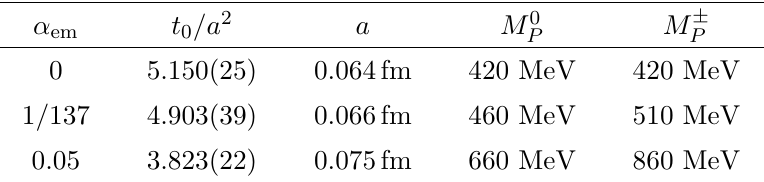
Table 1 . Values of t 0 in lattice units, and approximative values for the lattice spacing and pseu- doscalar meson masses in physical units. The values at α em = 0 are the CLS ones (H200 ensemble), and have been taken from [22]. The three ensembles share the same value of β = 3 . 55 and κ u = κ d = κ s = 0 . 137. For our simulations at α em = 0 we use q u = 2 / 3 and q d = q s = 1 / 3. The lattice spacing 6 − has been estimated by rescaling the CLS value with our measured a/ √ t 0 , and the error is estimated to be of order 10 − 3 fm. The error on our pseudoscalar masses is estimated to be of order 15 MeV. ensemble in ref. [22] with β = 3 . 55, κ = 0 . 137, c QCD sw ,⋆ = 1 . 824865, and complemented